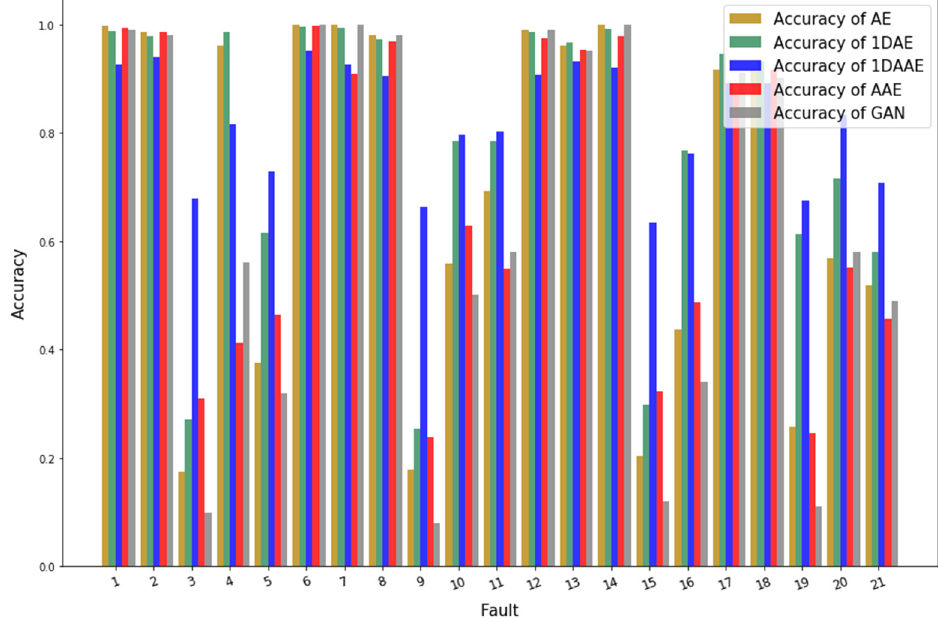
Figure 14. The fault detection results based on the AE, AAE, 1DAE, GAN, and 1DAAE.